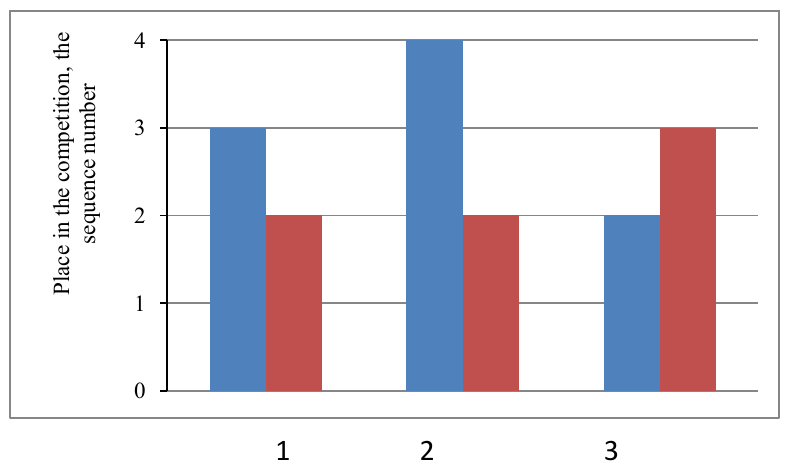
Fig.6. Indicators of performances of Ukrainian women’s combined team Lithuanian women’s combined team at world competitions for sportsmen with hearing